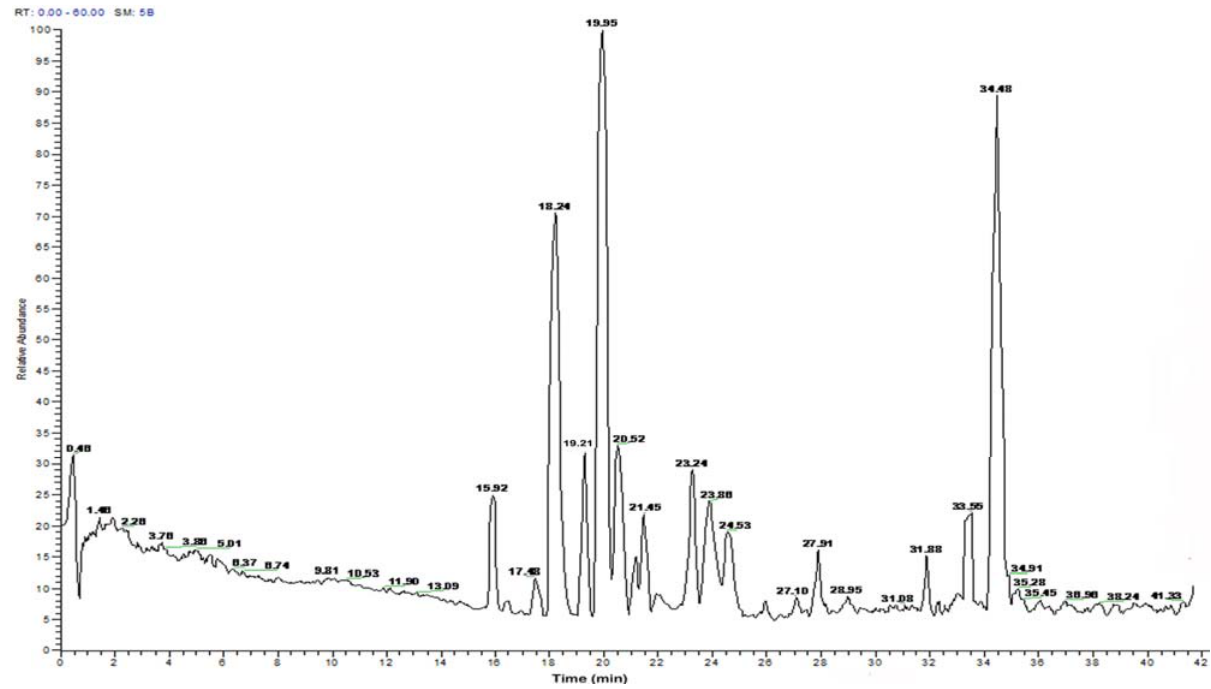
, 0.1 × 150 mm) of 18